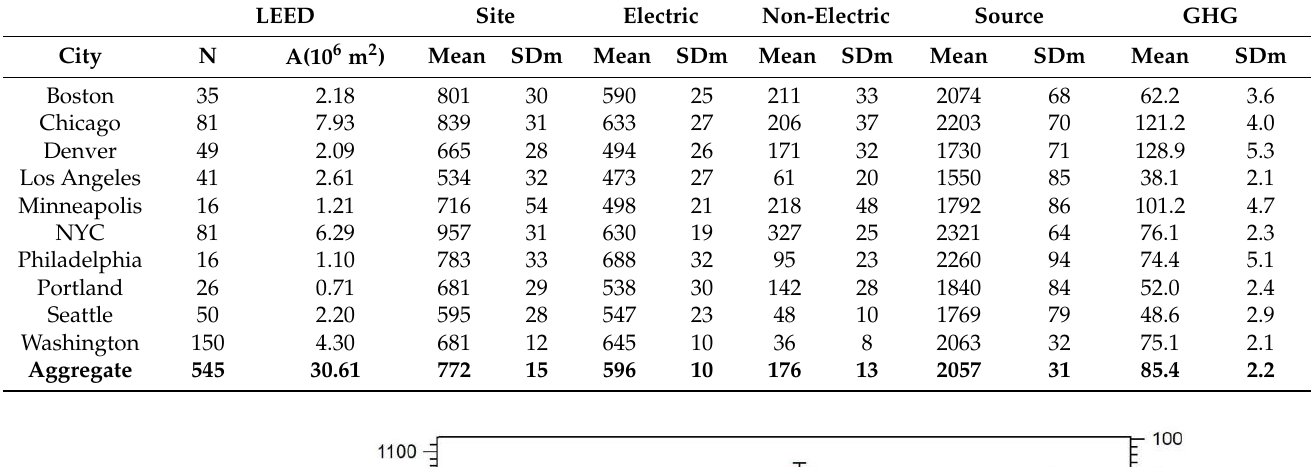
Table 2. Area weighted mean intensity metrics for LEED offices. SDm is the standard deviation of the weighted mean calculated using the bootstrap method with 10,000 replicates. Four energy intensities are in MJ/m 2 and GHG intensity in kg/m 2 .